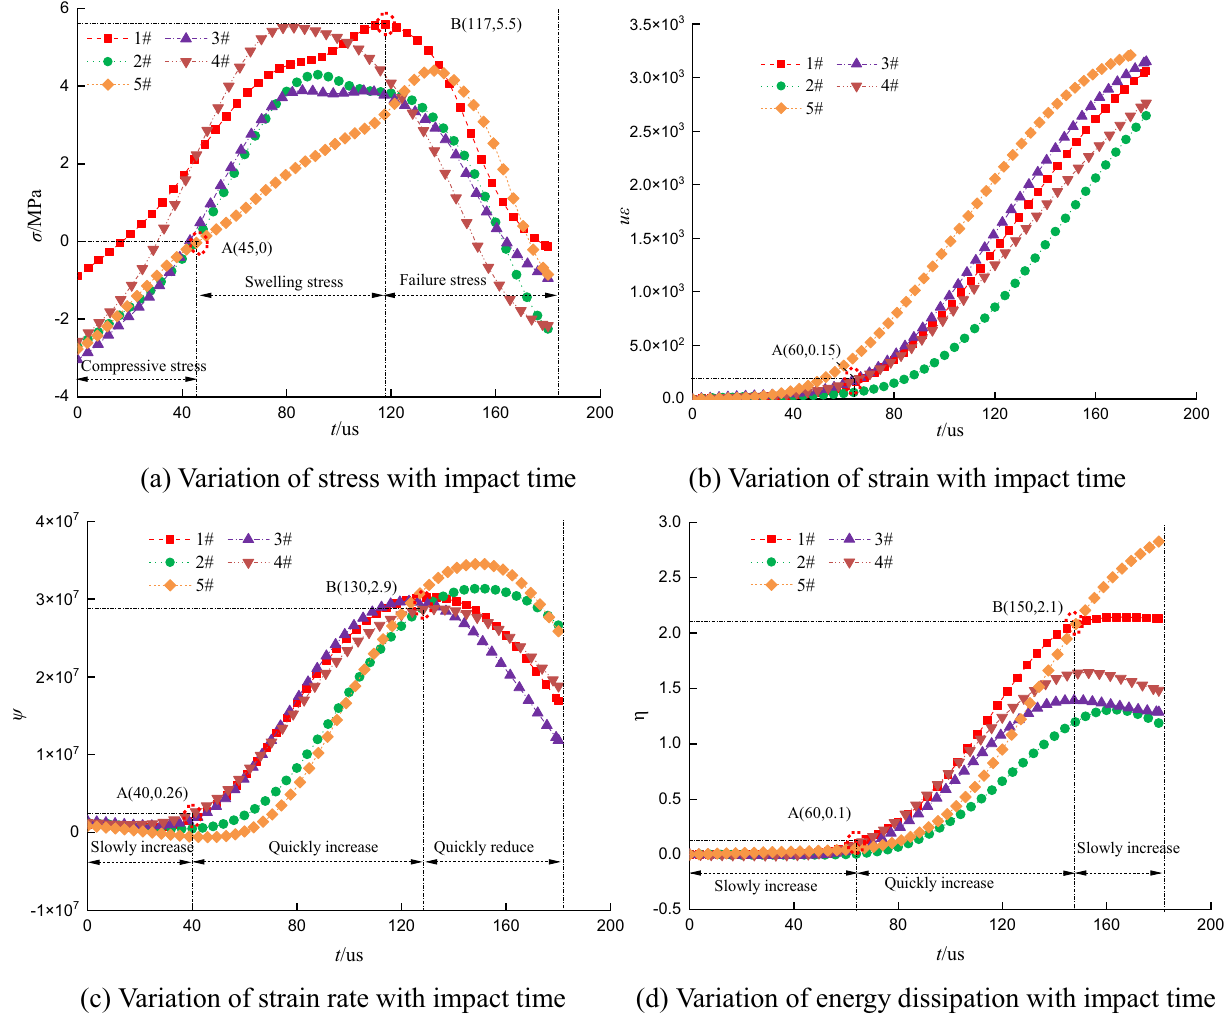
Fig. 3 Dynamic mechanical characteristics of coal with a water content of 30%. a Variation of stress with impact time; b Variation of strain with impact time; c Variation of strain rate with impact time; d Variation of energy dissipation with impact